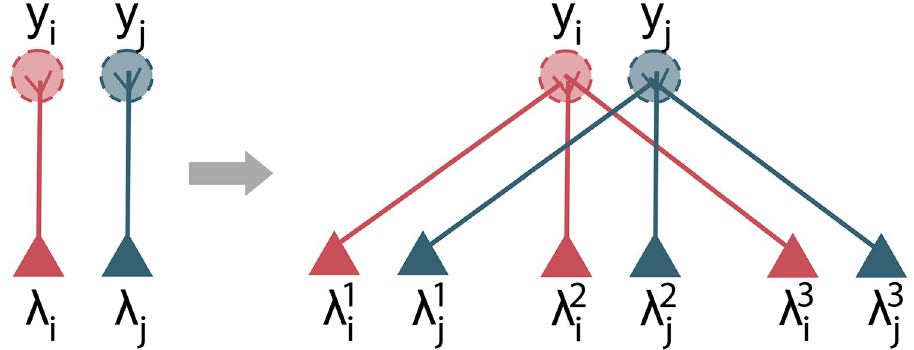
Fig 2. Sister cells. In the vertebrate olfactory bulb, each glomerulus, y , is sampled by not one (left panel) but approximately 25–50 ‘sister’ mitral and tufted cells, λ [22, 23] (right panel, with only three sisters to reduce clutter).